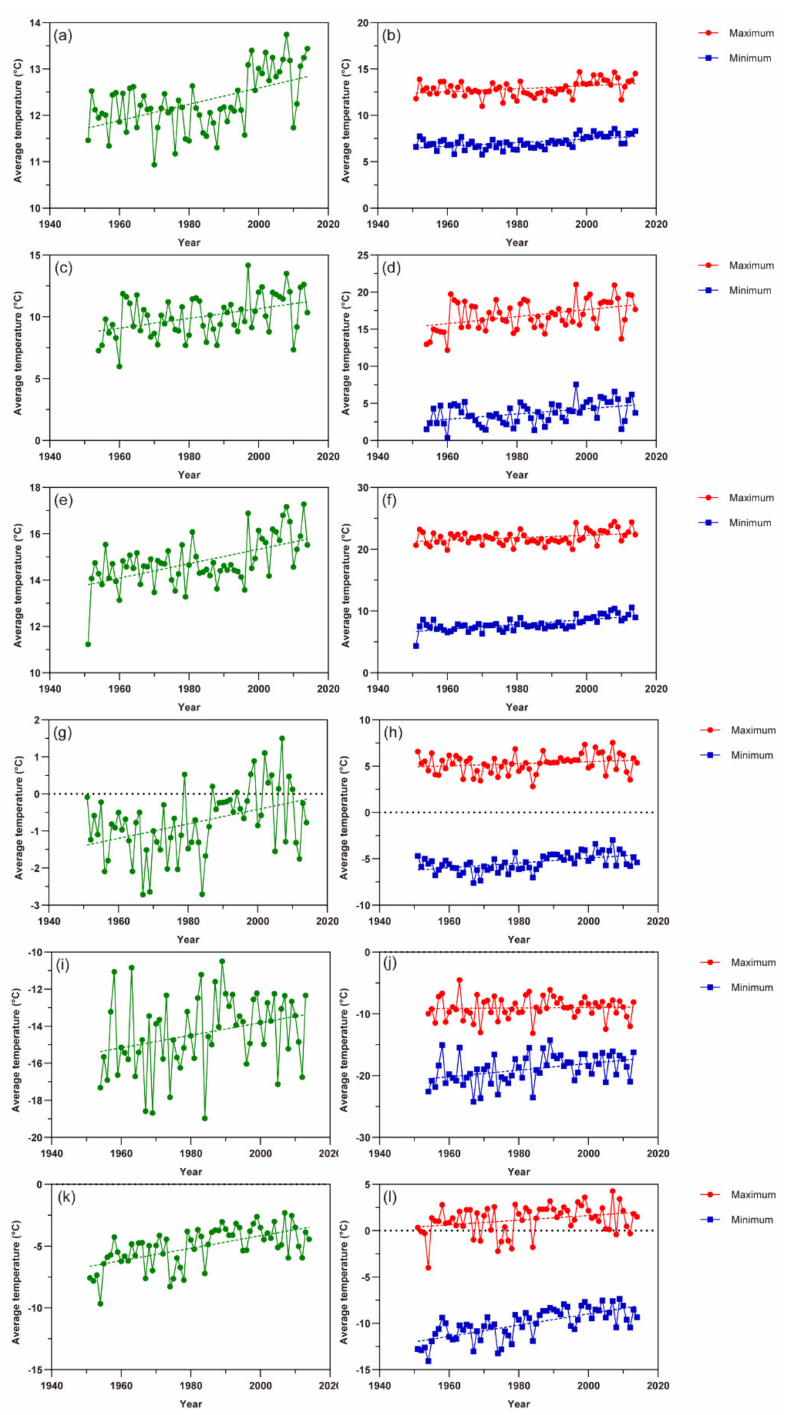
Figure 2. The change of the average temperature of spring (SAT) and winter (WAT) in China, as well as Xinjiang in recent decades (left column), and the change of the highest (SHT) and lowest (SLT) temperatures of spring (SHT, SLT) and winter (WHT, WLT) (right column). The dashed line with color shows the trend of temperature change. ( a ) SAT in China as a whole; ( b ) SHT and SLT in China as a whole; ( c ) SAT in northern Xinjiang; ( d ) SHT and SLT in northern Xinjiang; ( e ) SAT in southern Xinjiang; ( f ) SHT and SLT in southern Xinjiang; ( g ) WAT in China as a whole; ( h ) WHT and WLT in China as a whole; ( i ) WAT in northern Xinjiang; ( j ) WHT and WLT in northern Xinjiang; ( k ) WAT in southern Xinjiang; ( l ) WHT and WLT in southern